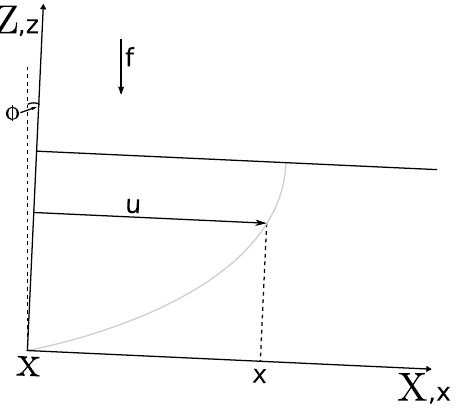
Fig. 1. Problem geometry of one-directional shearing flow of a slab of material down an uniformly inclined plate (UIP). The coordinate systems of the reference ( X ) and present ( x ) configurations are ori- ented concordantly, inclined by some angle φ relative to the gravi- tational force f acting in the